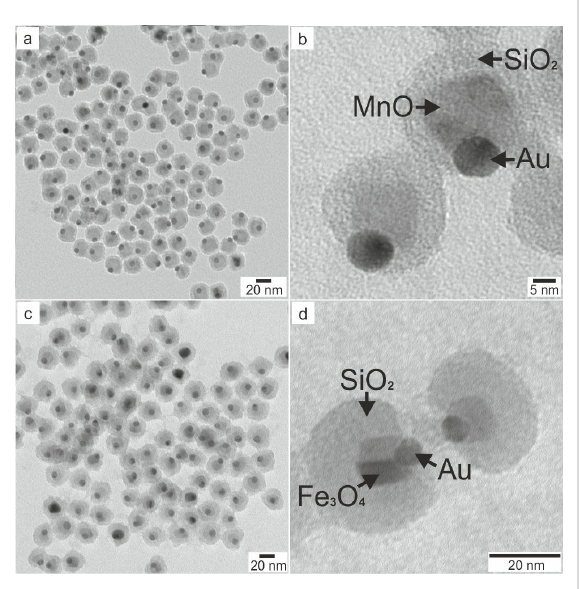
Figure 15: TEM micrographs of silica encapsulated Janus particles; (a,b) Au@MnO@SiO 2 (10@20 nm), and (c,d) Au@Fe 3 O 4 @SiO 2 (9@15 nm).